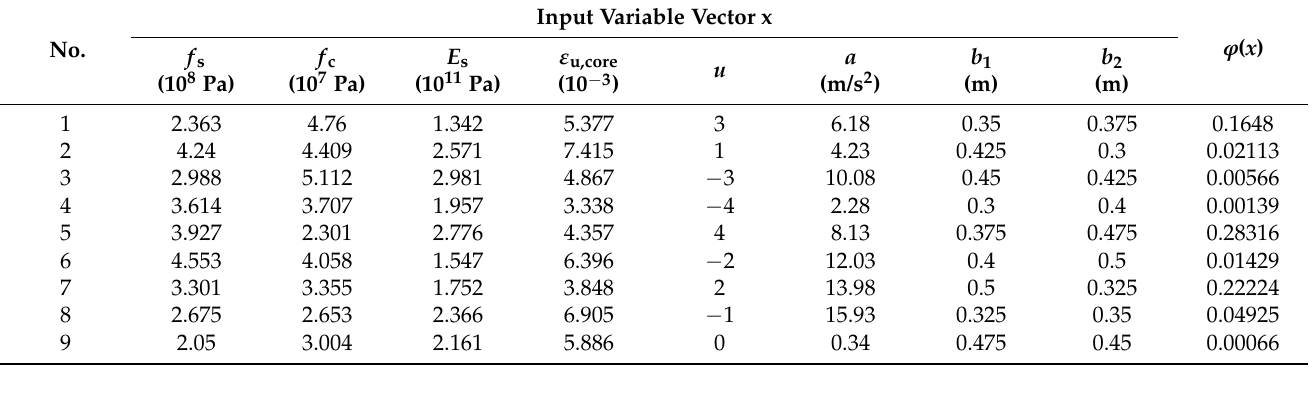
Table 5. Random parameters in Example 2.